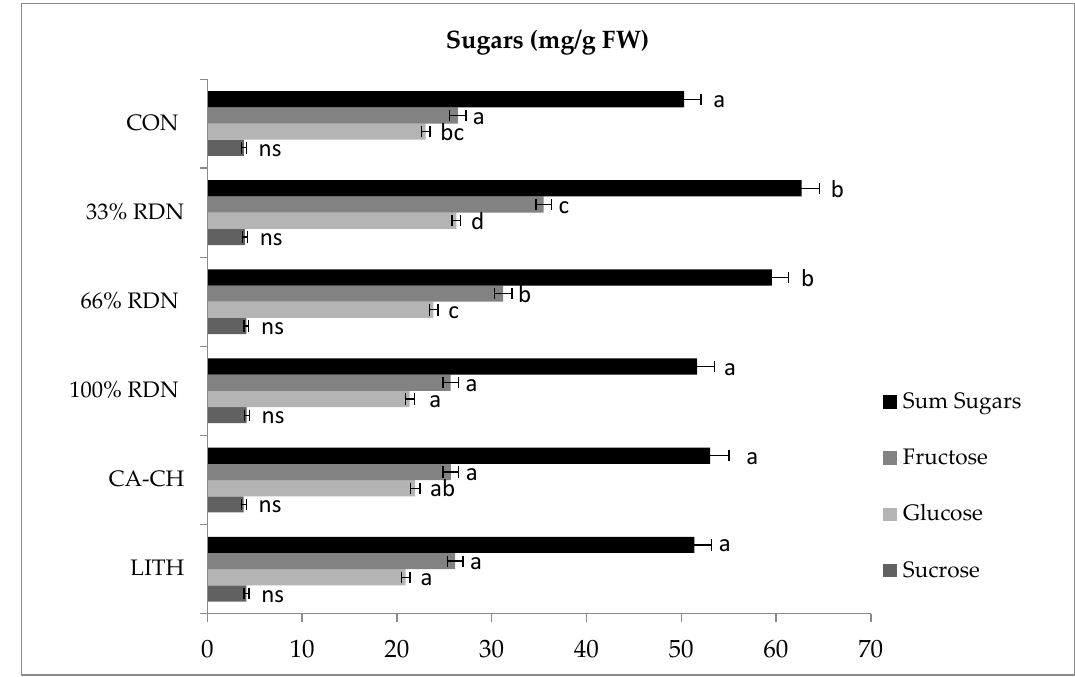
Figure 3. Strawberry sugar content following six treatments (33%, 66% and 100% RDN, CA-CH, LITH and CON). Average means ( n = 10) ± standard errors are shown. Different letters between treatments denote significant differences (Tukey test, p < 0.05). RDN—recommended dose of nitrogen; CA-CH—calcium chelate; LITH—Lithovit; CON—control.